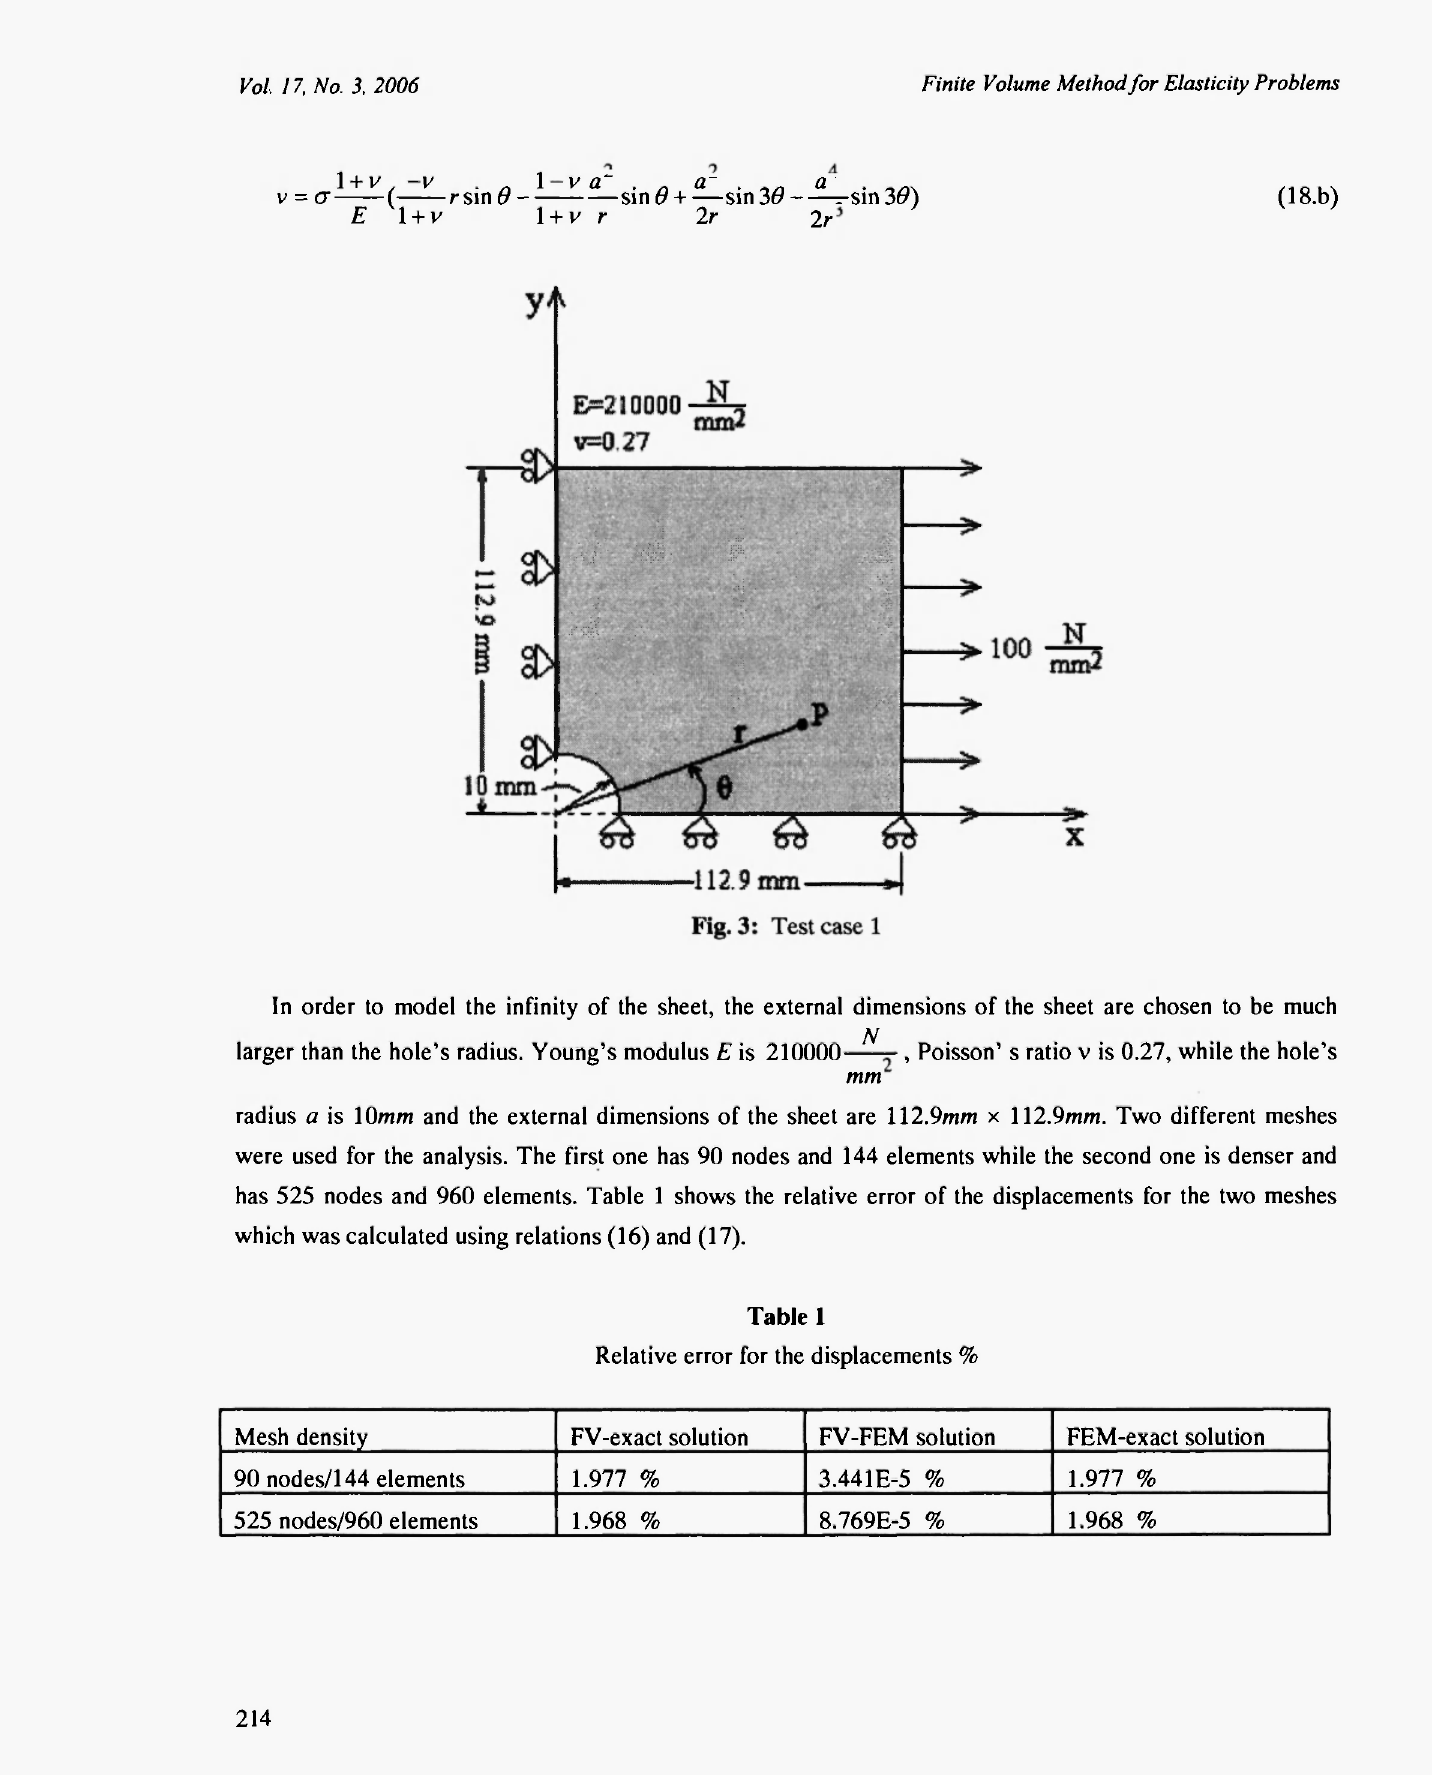
Relative error for the displacements